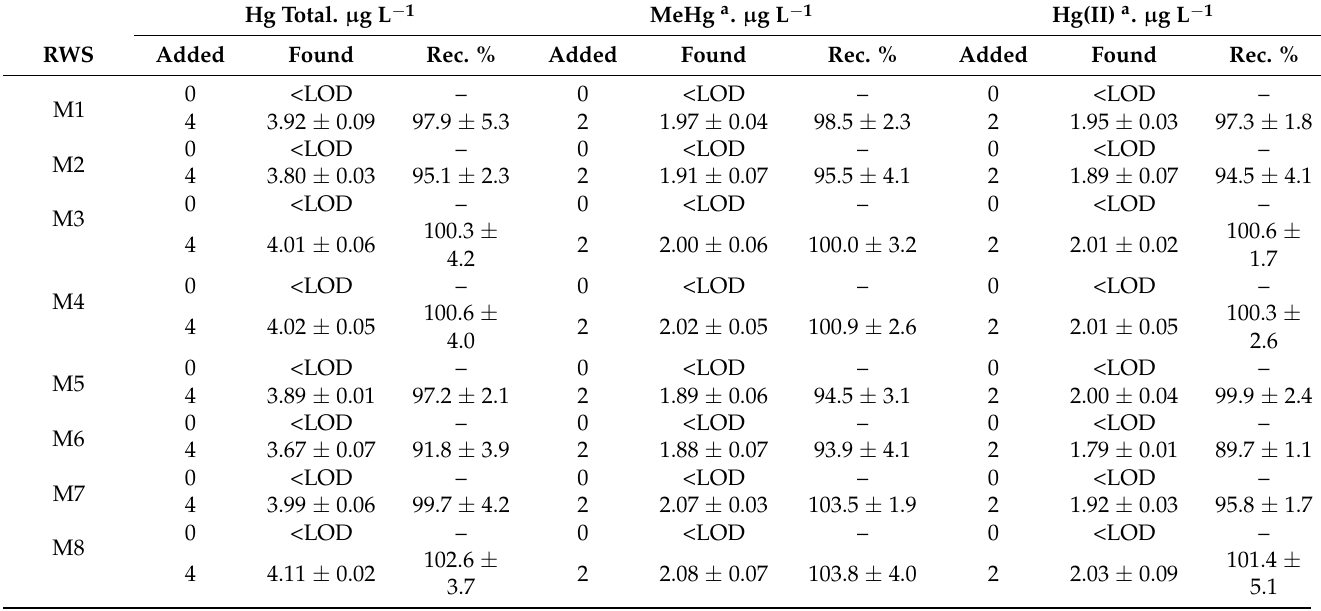
Table 4. Total mercury, Hg(II) and MeHg in real water samples